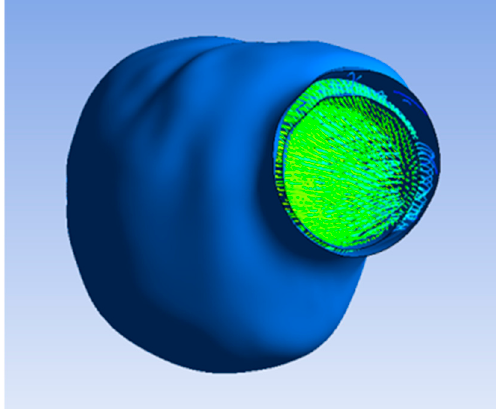
Figure 6. Flow not penetrating aneurysm wall.